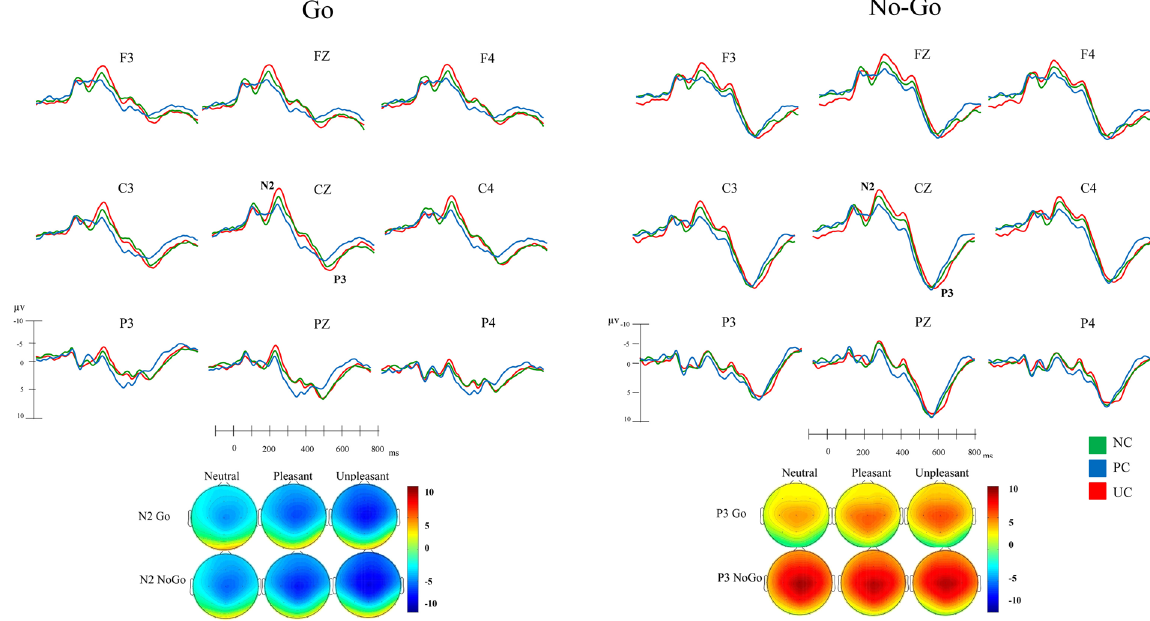
Figure 2. Top panel: ERP waveforms during Go and NoGo trials in each context condition: neutral (NC), pleasant (PC) and unpleasant (UC). Bottom panel: the topographical distribution of N2 and P3 is shown. The color scale represents microvolt values, with scales adjusted independently for N2 and P3. For N2, blue corresponds to maximum negativity; for P3, red corresponds to maximum